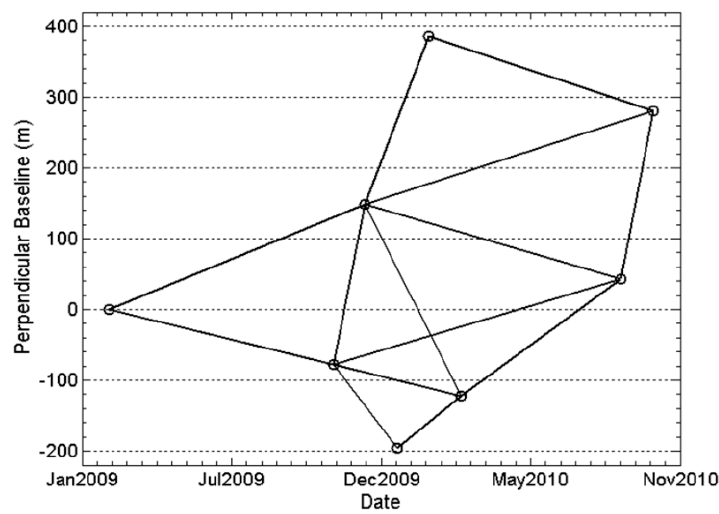
Figure 2. Configurations of Interferometric Synthetic Aperture Radar (InSAR) pairs used for the basin ground deformation monitoring.